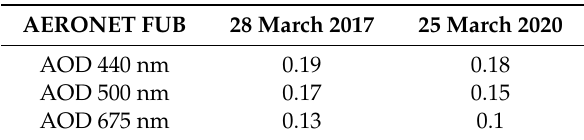
Table A3. Aerosol optical depth (AOD) for the three wavelengths in the visible range obtained from the AERONET measurement station at Freie Universität Berlin.